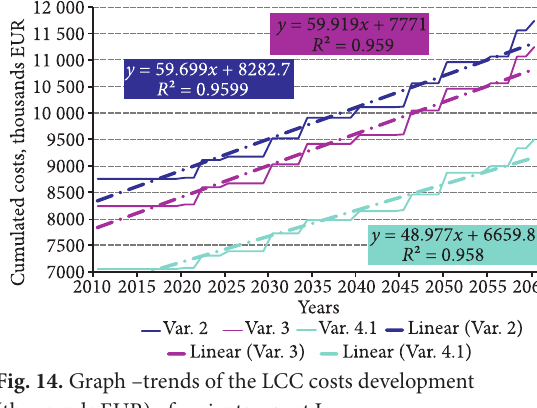
Fig. 14. Graph –trends of the LCC costs development (thousands EUR) of variants – part